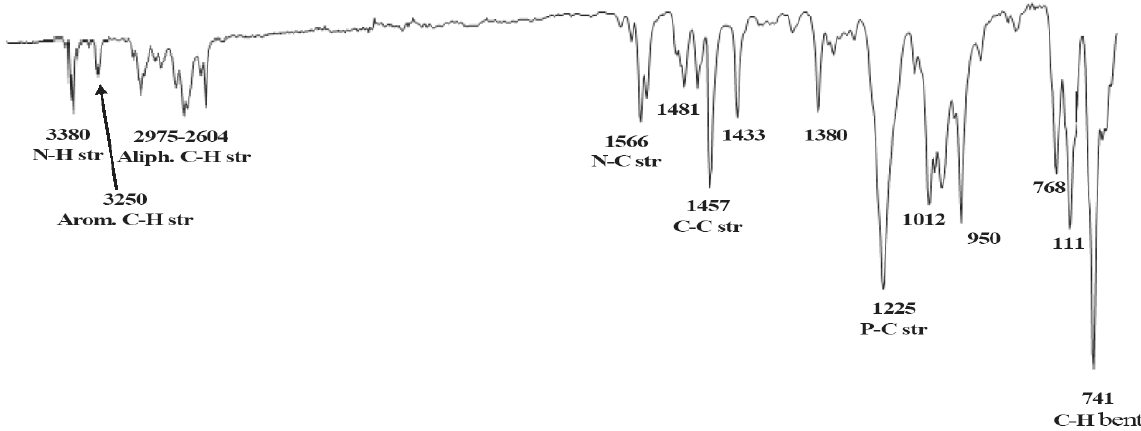
Figure 8. Infra-red spectrum cm -1 per well-known function group of complex 1